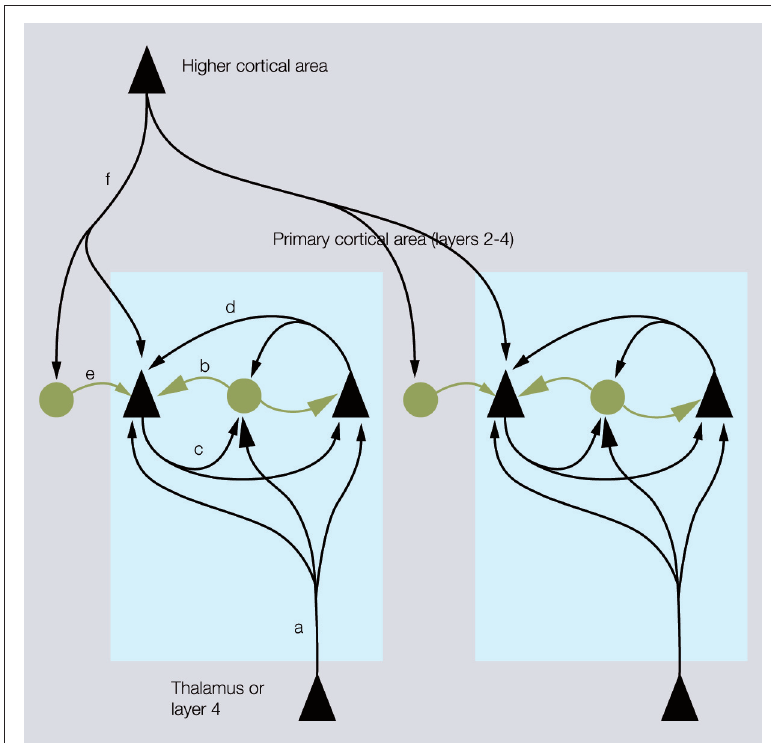
Figure 4 | Inhibitory networks involving fast spiking parvalbumin (PV)-expressing neurons in thalamocortical, interlaminar and interareal cortical circuits. Feedforward excitatory thalamocortical inputs to spiny neurons ( ▲ ) and fast spiking interneurons (•) in layers 2–4 (a) . Inputs to interneurons are stronger (large arrowheads) than inputs to spiny cells. PV neurons provide strong (large rectangular endings) feedforward inhibition (b) to spiny cells. Feedback inhibition (c) results from PV neurons that are excited by the same spiny neurons that they inhibit. These reciprocally connected spiny neuron/PV neuron pairs share common inputs (e.g., cells in layer 4 from thalamus or cells in layer 2/3 from layer 4) creating recurrent excitatory (d) and inhibitory subnetworks (contained within blue shaded boxes). ‘Lateral’ inhibition (e) of these subnetworks results from PV neurons that are driven by excitatory feedback connections (f) from outside the subnetworks (e.g., by layer 5 to layer 2/3 connections or feedback from higher cortical areas). Notice that ‘lateral’ inhibition is weaker (small rectangular endings) than feedforward and feedback inhibition and impinges on multiple